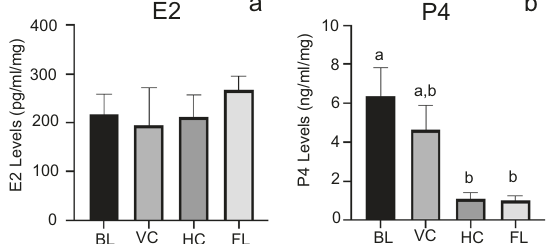
Fig. 3 Whole ovarian tissue estrogen and progesterone concen- trations. a Estradiol (E2; pg/ml/mg tissue) and b progesterone (P4; ng/ml/mg tissue) levels for all mice within a treatment group ( n = 8-9/treatment; 9BL, 8VC, 9HC, 9FL). a,b Means ± SEM with different superscripts are signi fi cantly different ( p ≤